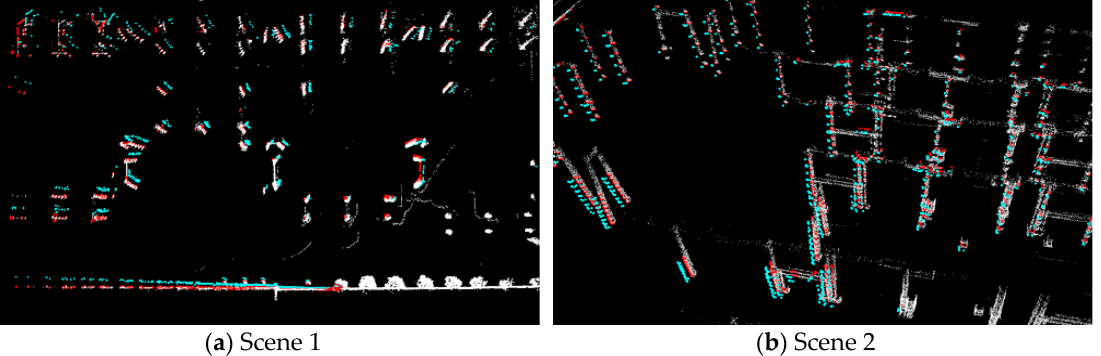
Figure 3. An example of the matching process.